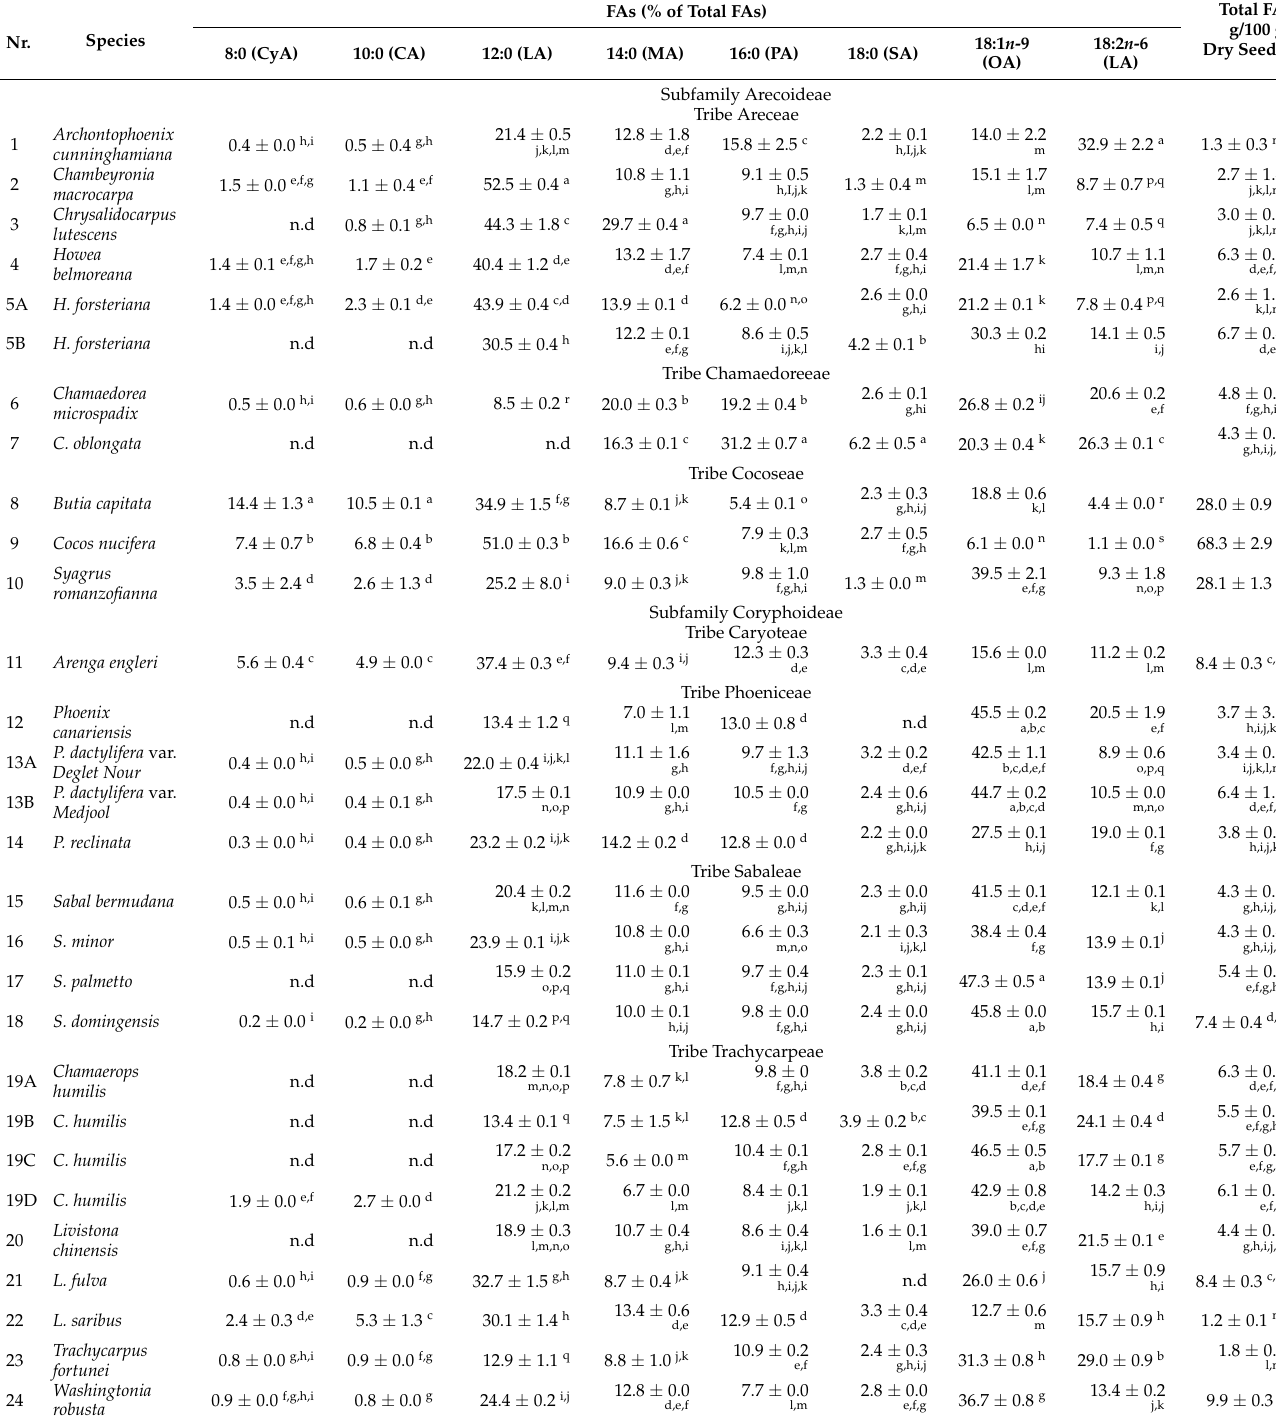
Table 1. Fatty acid profiles of seeds from Arecaceae species a,b,c